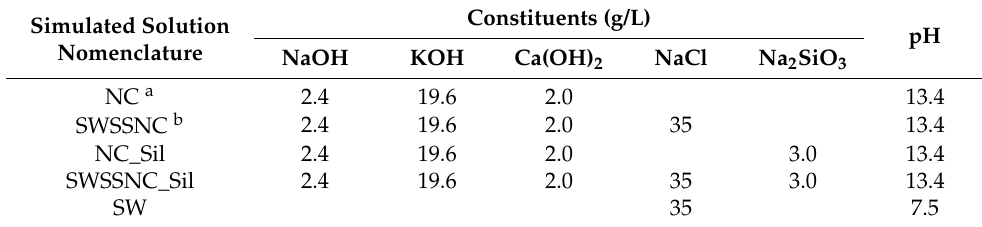
Table 1. Chemical composition and pH of test solutions.